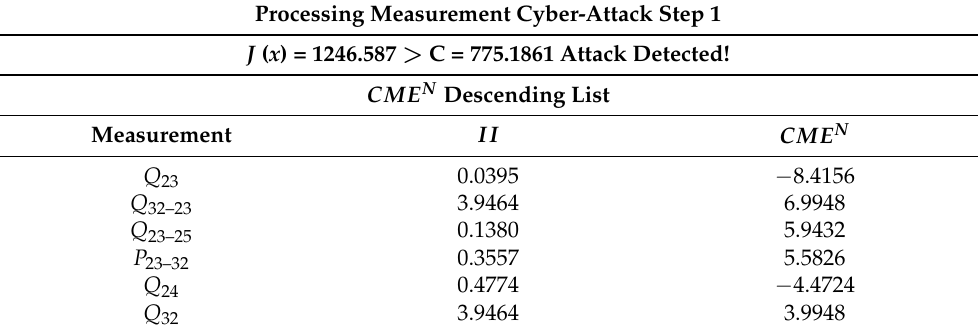
Table 1. Processing cyber-attacks.